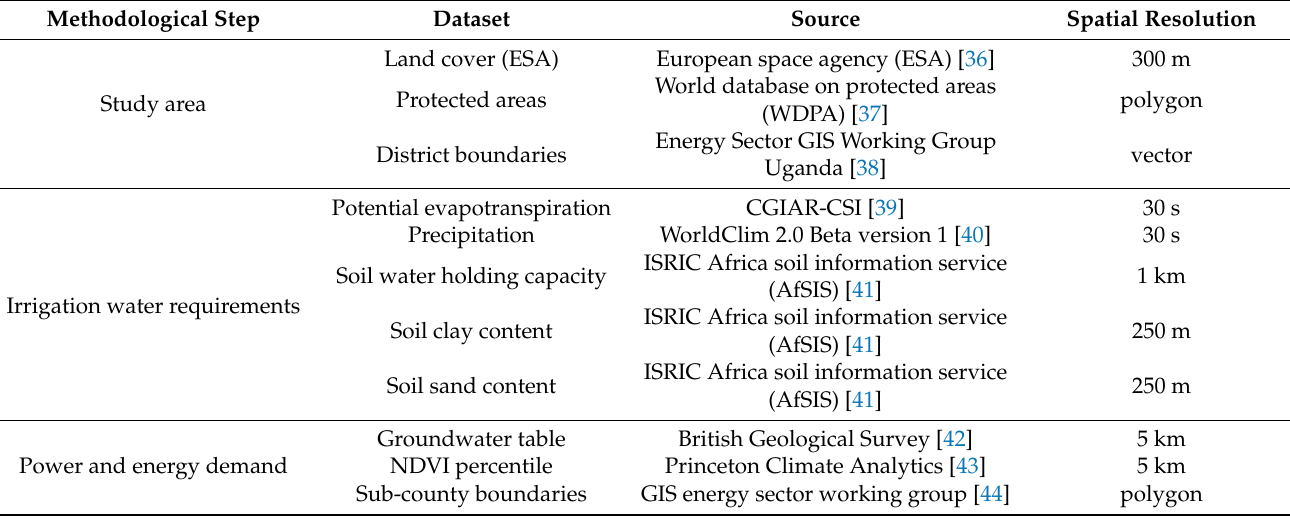
Table 1. Spatial data parameters and